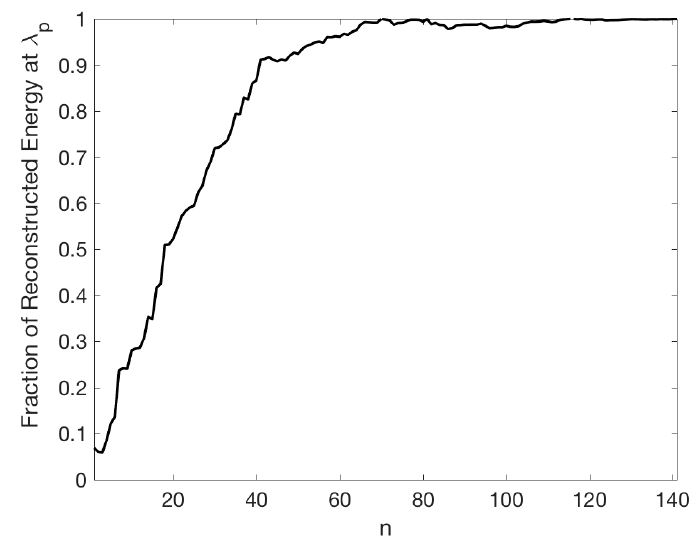
Figure 2. Energy contained in the 1 to n mode reconstruction at the buoy-based peak wavelength normalized by the total energy in the radar measurement at that wavelength (dataset 14).